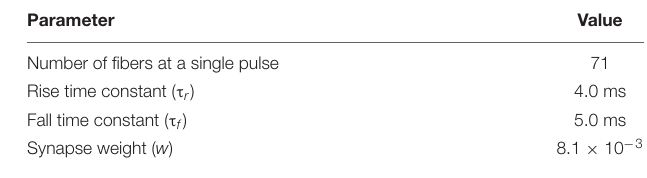
TABLE 3 | Estimated synaptic model parameters based on the measured results.